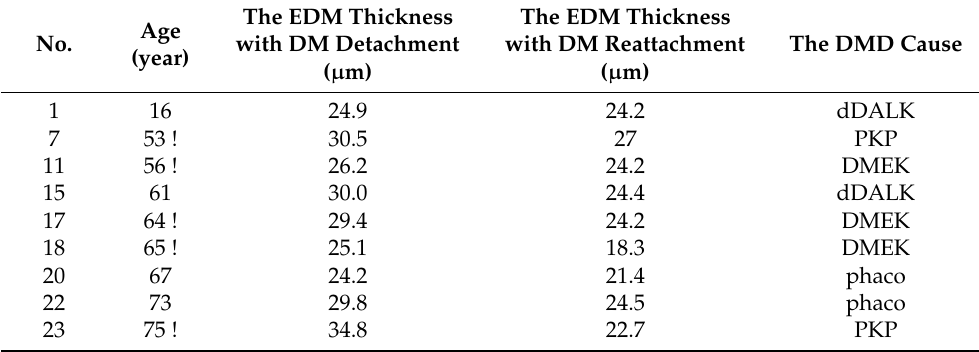
Table 3. Data of 9 subjects whose boundary between the corneal stroma and DM were clear in HD-OCT images after DM